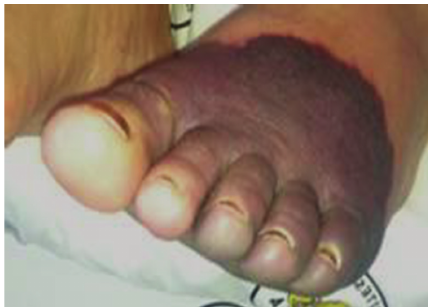
Figure 1: The cyanotic lesion in left